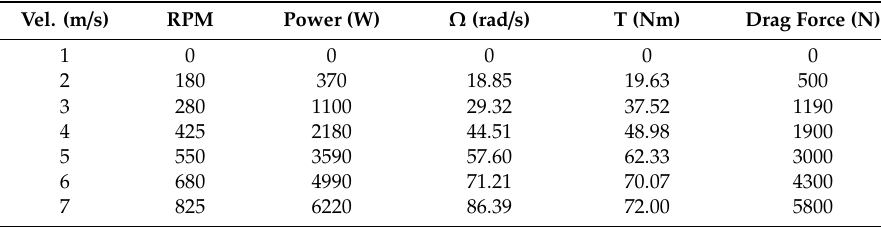
Table 4. Mechanical load output of 34.9 Ω .